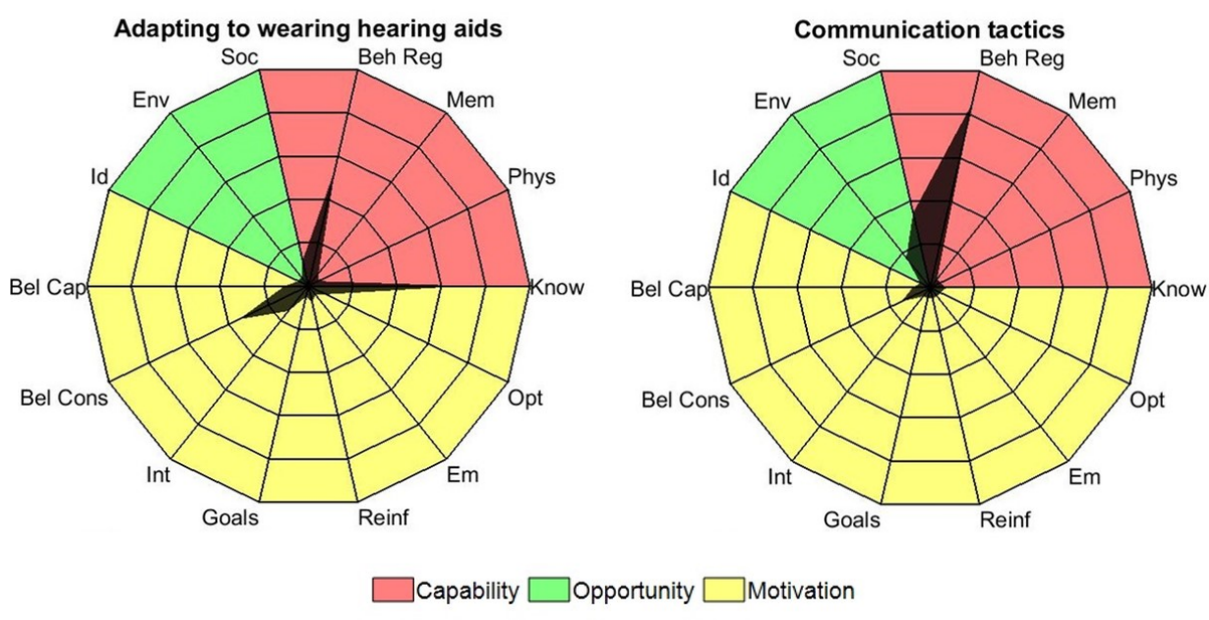
Figure 1. Radar chart showing the proportion of time the theoretical domains framework (TDF) factors were included in the communication tactics and adapting to wearing your hearing aids C2Hear reusable learning objects (RLOs). Percentages are plotted for the 14 TDF factors on individual axes. Concentric grid lines connecting axes increase in 20% increments, from 0% (center point) to 100% (outer edge). Each data point has been connected to form the black shaded